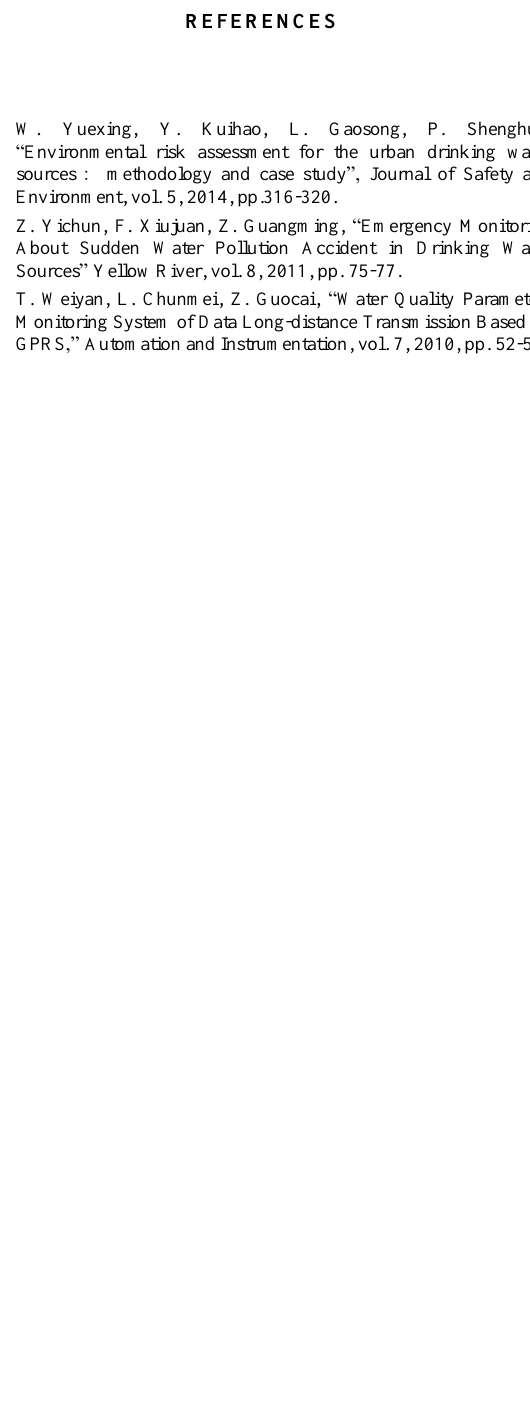
Figure 4. Daily monitoring